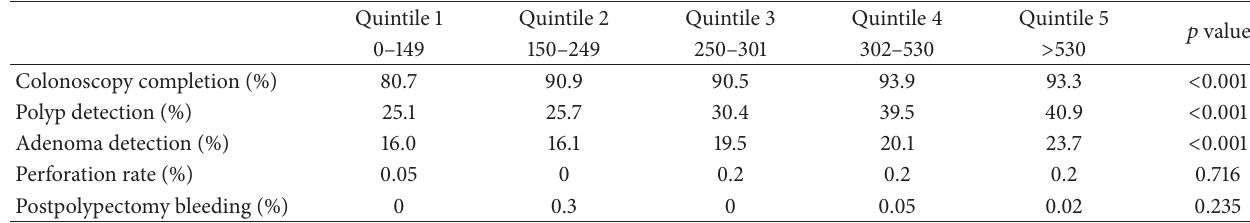
Table 2: Quality indicators and their relationship to annual colonoscopy volume